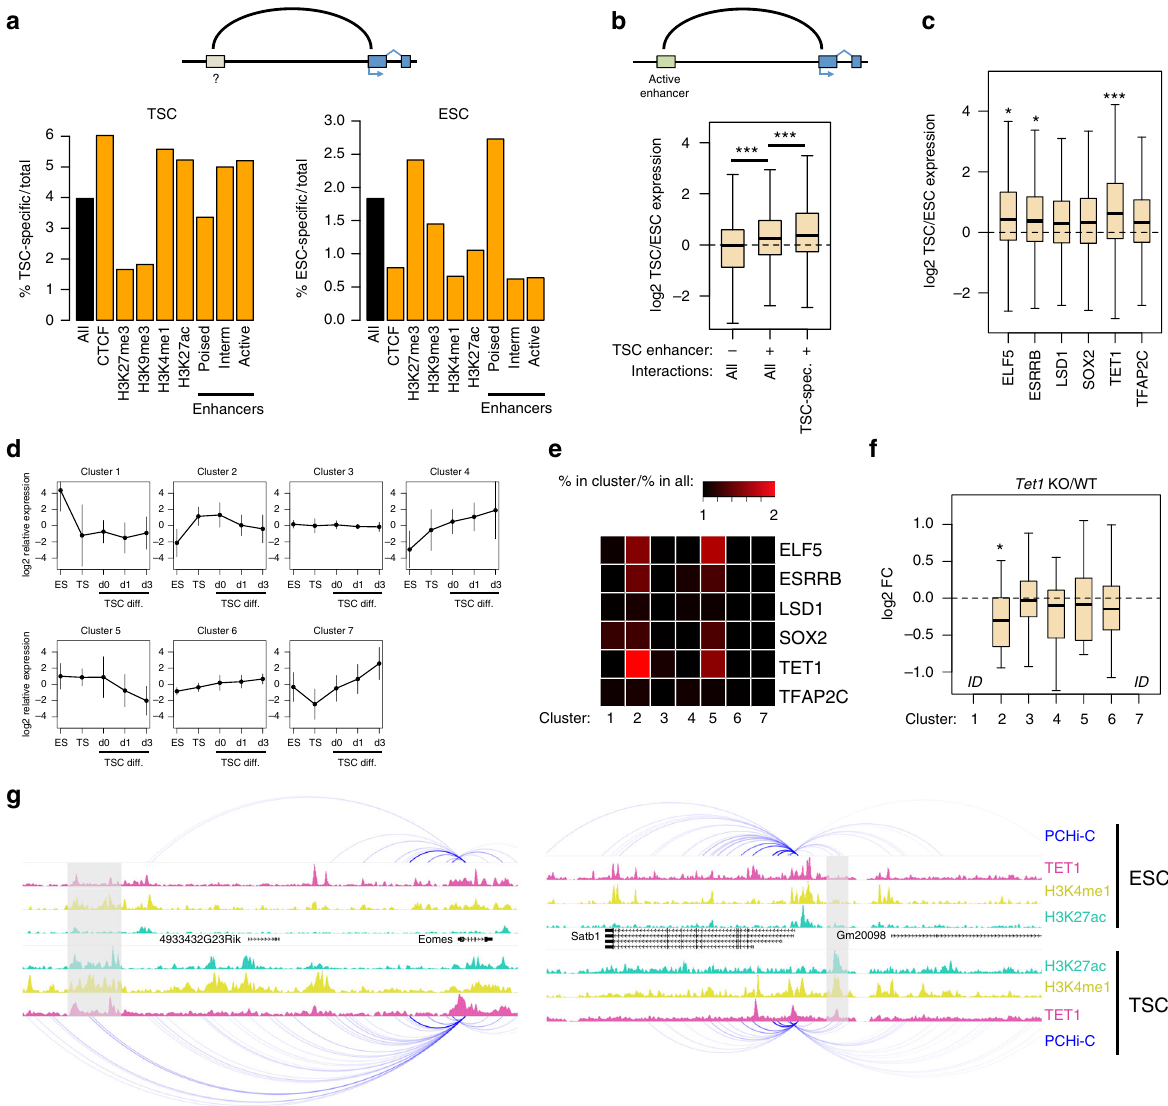
Fig. 4 TSC-speci fi c interactions involve TET1-regulated genes. a Percentage of cell-speci fi c interactions among all interactions (black bars) or promoter – genome interactions with the indicated proteins/modi fi cations/features (orange bars). b Expression ratio (log2) between TSCs and ESCs for genes involved in interactions (all or ESC-speci fi c) with active enhancers, and compared with genes that do not interact with any active enhancer. *** p < 0.0005 ( t- test, corrected for multiple comparisons). c Expression ratio (log2) between TSCs and ESCs for genes involved in interactions with active enhancers bound by the indicated transcription factors in TSCs. * p < 0.005, *** p < 0.00005, compared to LSD1 (ANOVA with Tukey post hoc test). d Relative expression pro fi les of genes grouped by k-means clustering based on expression in ESCs, TSCs and differentiating TSCs (days of differentiation are indicated). Error bars represent standard deviations. e Heatmap displaying the enrichment of genes interacting with enhancers bound by the indicated transcription factors in each cluster (relative to the abundance across all clusters). f Expression ratio (log2) between Tet1 KO and WT TSCs for genes interacting with enhancers bound by TET1 in each cluster. ID indicates insuf fi cient data. * p < 0.01, compared to all genes (ANOVA with Tukey post hoc test). g Examples of TET1-regulated genes displaying interactions with TET1-bound enhancers in TSCs. Grey boxes highlight TET1-bound enhancers in TSCs. Boxplot midline represents median, box edges the fi rst and third quartiles, and whisker edges are the last data points within 1.5× the